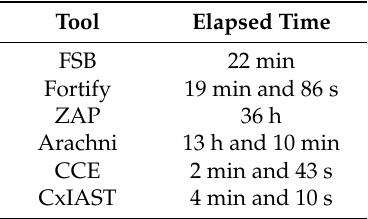
Table 4. Execution times of each tool against OWASP Benchmark project.